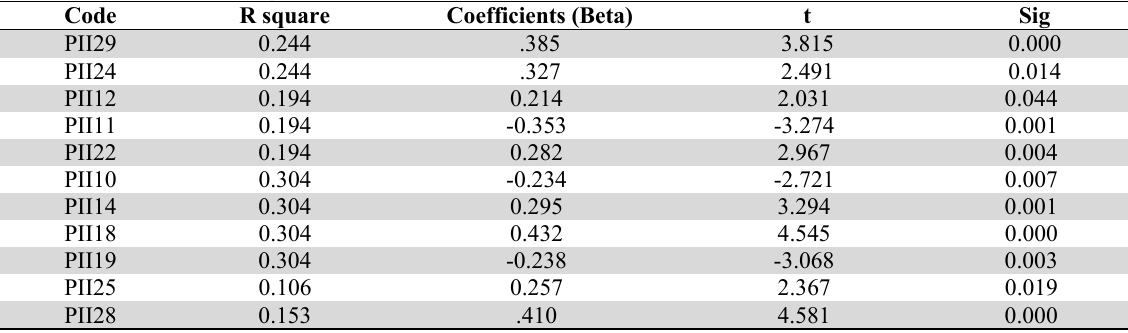
Summary result from regression model (Customer satisfaction) Code R square Coefficients (Beta)